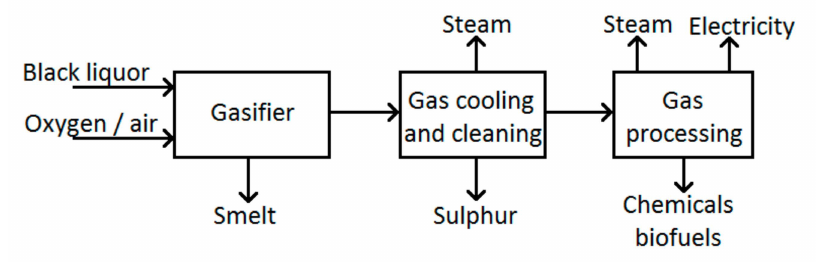
Figure 1. Simplified scheme of black liquor gasification.